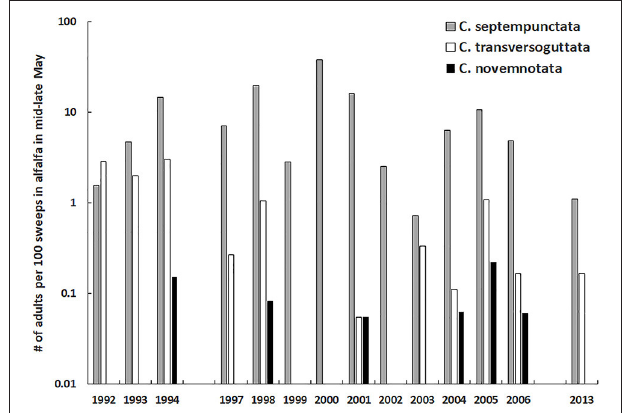
FIGURE 1 | The number of adults of Coccinella spp. ( C. septempunctata , C. tranversoguttata , and C. novemnotata ) per 100 sweeps in alfalfa fields in northern Utah (Cache Valley), as sampled in mid to late May, 1992–2013 (note log scale for